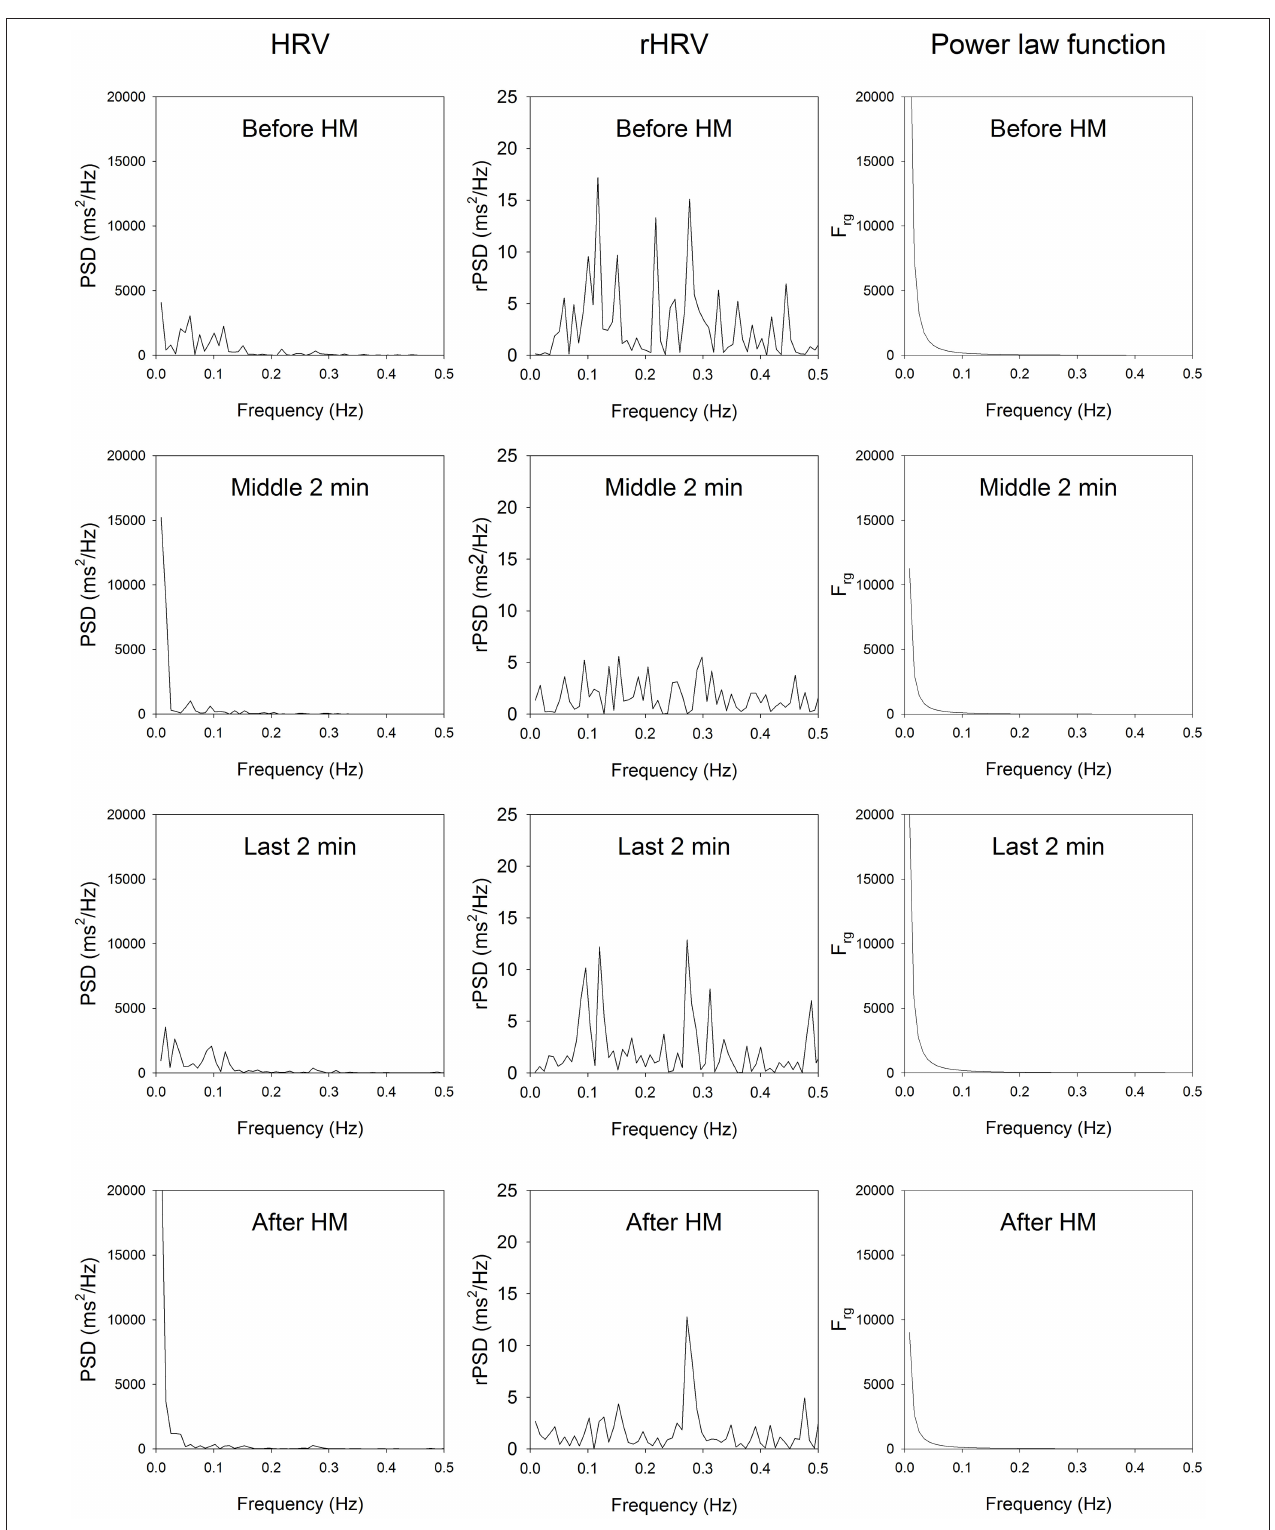
FIGURE 1 | HRV spectrum, residual HRV spectrum and the power law function of a representative participant. Top, before HM; middle upper panels, middle of HM; middle lower panels, last 2min of HM; bottom panels, imposed breathing after HM. In all stage of HM and after HM, the very low-frequency part of the rHRV is reduced, the low-frequency part of rHRV is reduced, while the high-frequency part of the rHRV is enhanced.